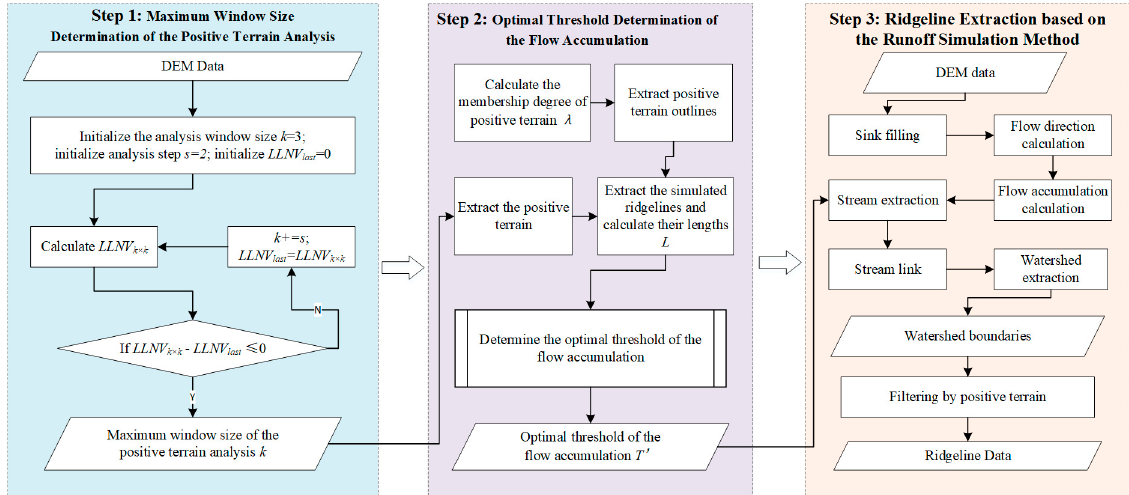
Figure 3. Processes of the positive terrain-constrained ridgeline extraction.